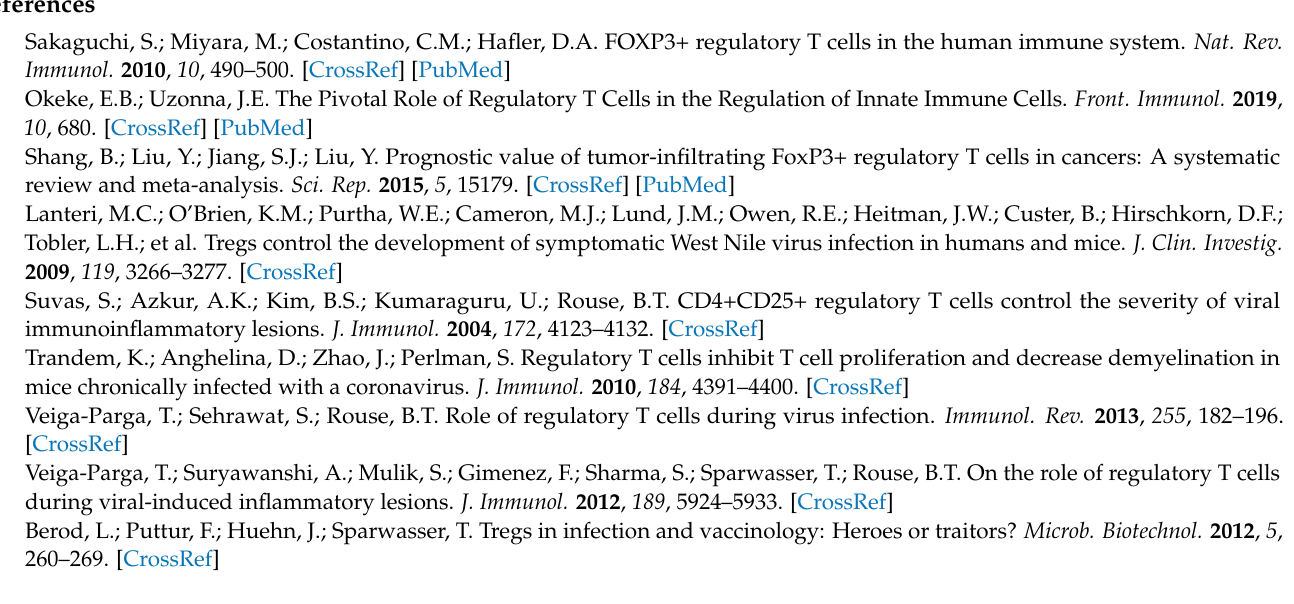
Figure A1. IL − 2/anti − IL − 2 complex expands the Treg population . Mice were either injected with IL − 2/anti − IL − 2 complex or left as control for 3 consecutive days after which splenocytes were isolated and analyzed for Tregs using flow cytometry. ( A ) Gating strategy. Tregs were isolated from the spleen of C57BL/6 mice injected with the IL − 2/anti − IL − 2 complex. The cells were then analyzed for live/dead, CD4, CD8, CD25, and Foxp3 expression. Freshly isolated Tregs were assessed for their purity before the experiments were carried out. ( B ) Representative contour plots of CD4 + CD25 + Foxp3 + Tregs after injecting animals with the IL − 2/anti − IL − 2 complex. ( C ) Bar graph showing the % of CD4 + CD25 + Foxp3 + T-cells after injecting the IL − 2/anti − IL − 2 complex. The experiment was performed 3 times with n = 3 and the data are presented as mean ± SE. **** p <